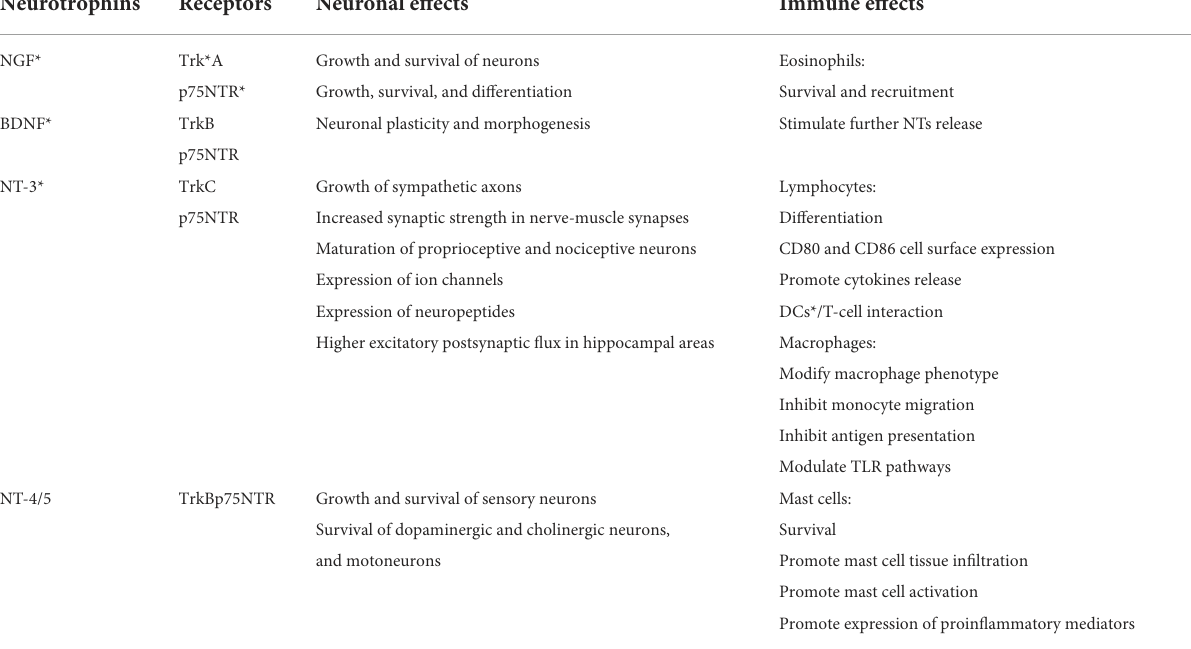
TABLE 1 The neurotrophins: their receptors and neuronal and immune